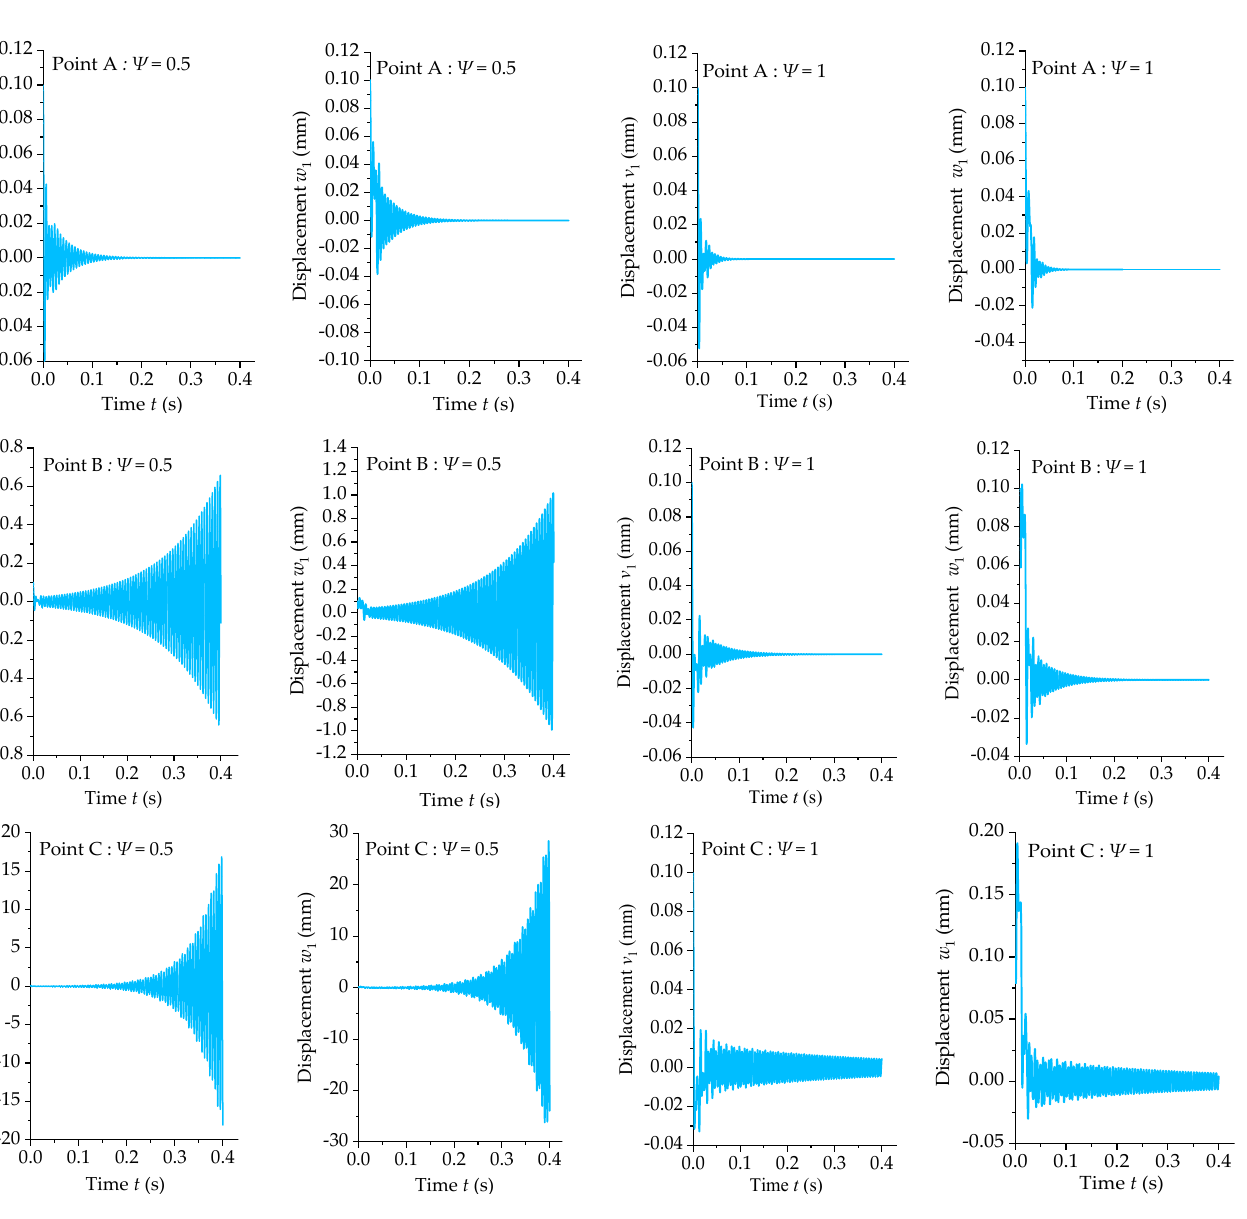
Figure 13. Displacement response curves of Points A, B, and C. Table 4. Rotation speeds and cutting depths of the different points in Figure 11.